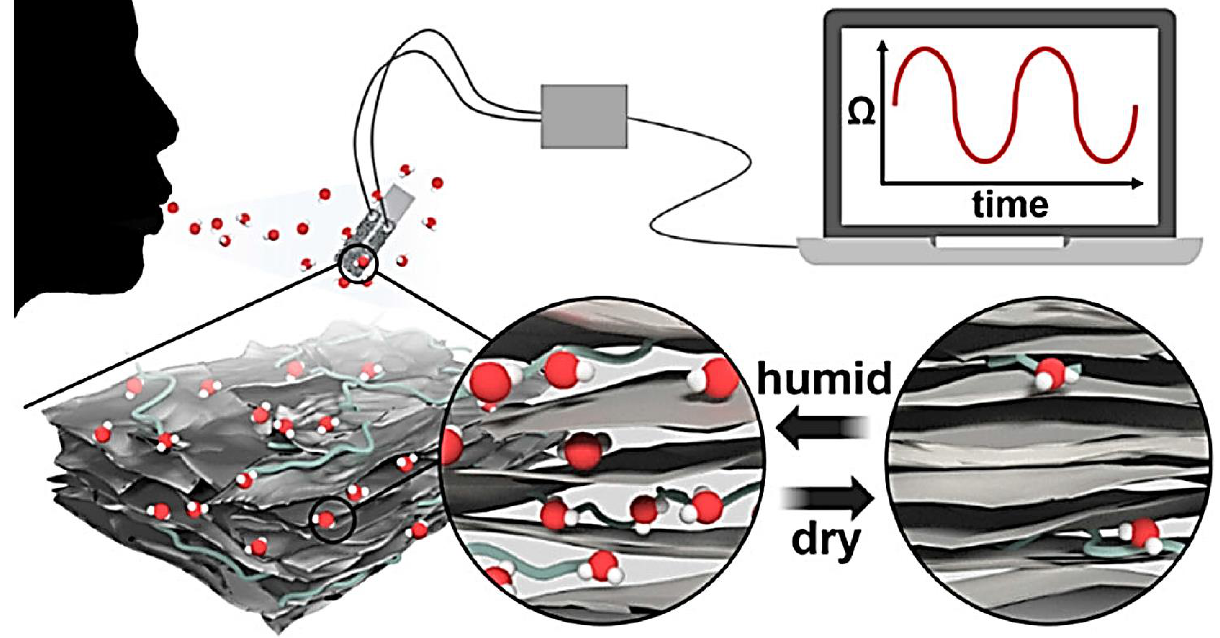
Figure 9. Polyelectrolyte/MXene Multilayers detector of human respiration (Reprinted with permis- sion from Reference [141]. Copyright 2017 American Chemical Society).